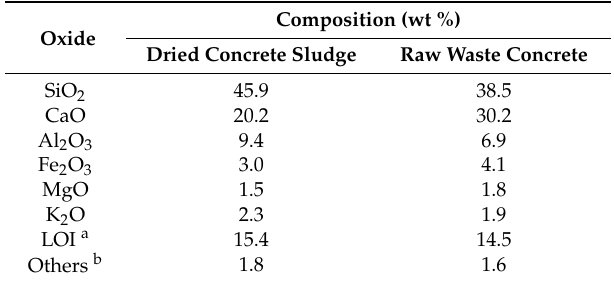
Table 2. Chemical composition of dried-solid particles in concrete sludge (XRF